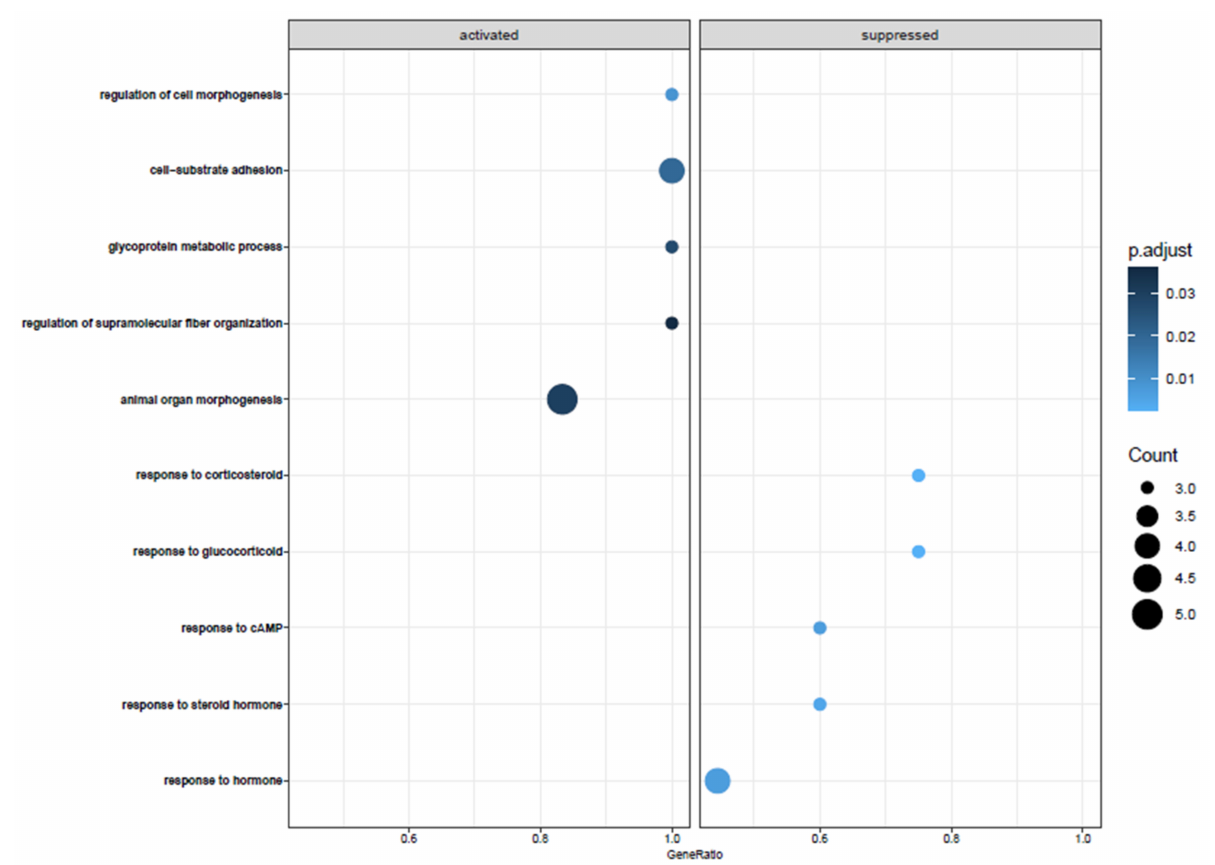
Figure 4. The GeneOntology analysis of all significant 101 genes that are differentially expressed between ADSCs after 48 h of incubation and uncultured ADSCs. Activated and suppressed pathways Normalized Enrichment Score (NES) is calculated by the LogFoldChange values. It revealed change in a plentitude of different biological functions, such as downregulation of fat-associated metabolism hormone processes and an upregulation of extracellular-matrix-associated